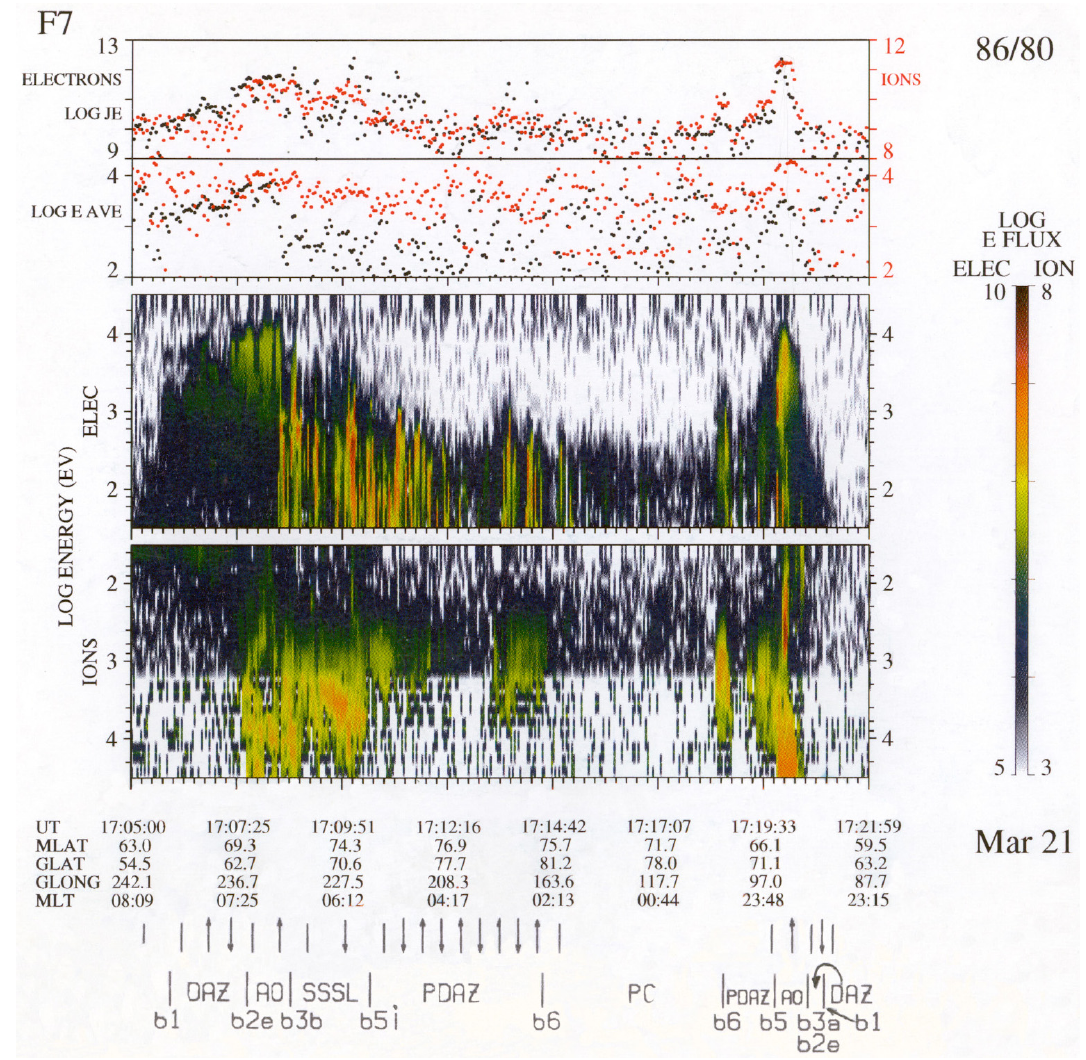
Fig. 10. The same as Fig. 2, except for the spectrogram on 21 March 1986, 1705–1722 UT.